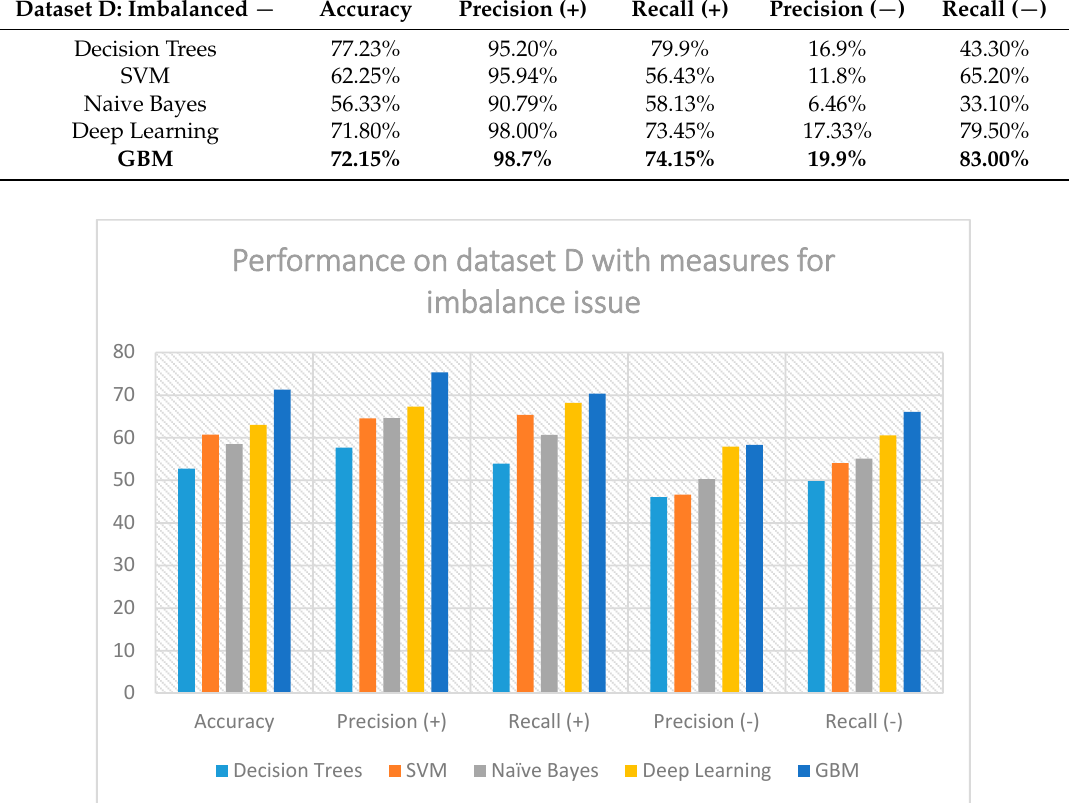
Figure 5. Evaluation scores of all classifiers against the negative imbalanced set upon taking measures for the class imbalance problem.